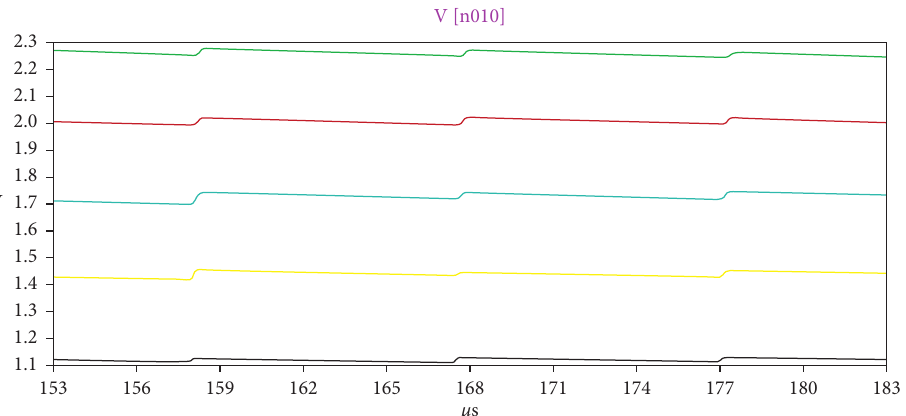
Figure 20: Current to rectified voltage